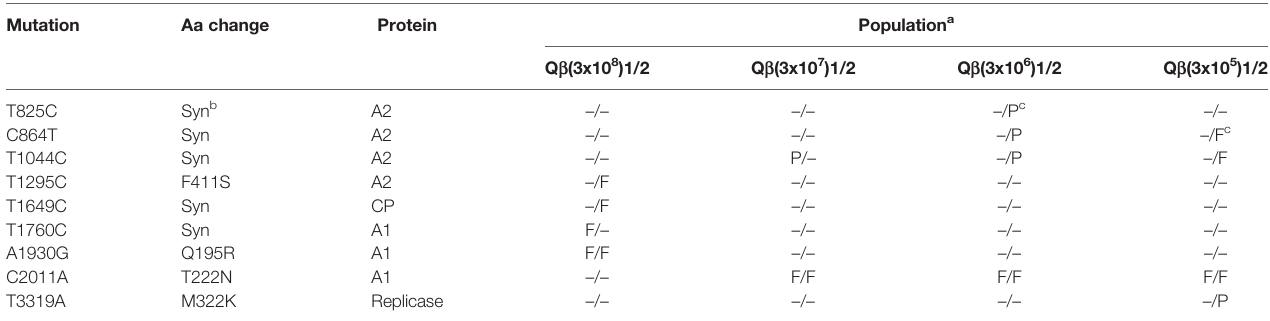
a Populations are denoted as indicated in Figure 1 . The numbers 1 and 2 represent the two replicas performed for each evolutionary lineage. b Syn indicates a synonymous mutation. c Polimorphic mutations are indicated with a P and those fi xed with an F.